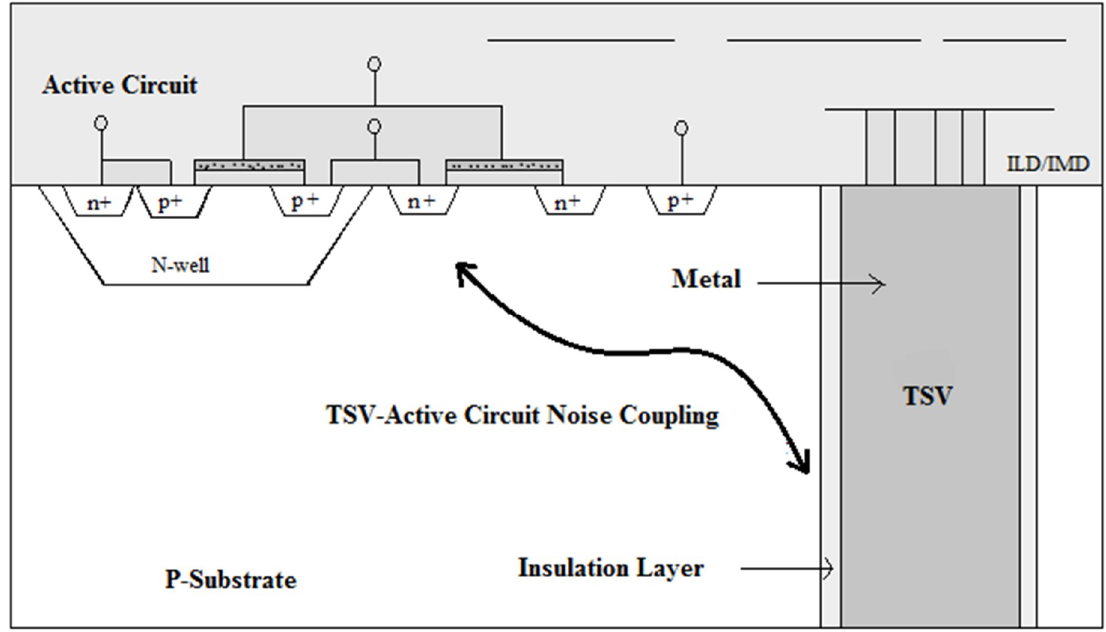
Figure 3. The conceptual view of TSV–active circuit noise coupling.